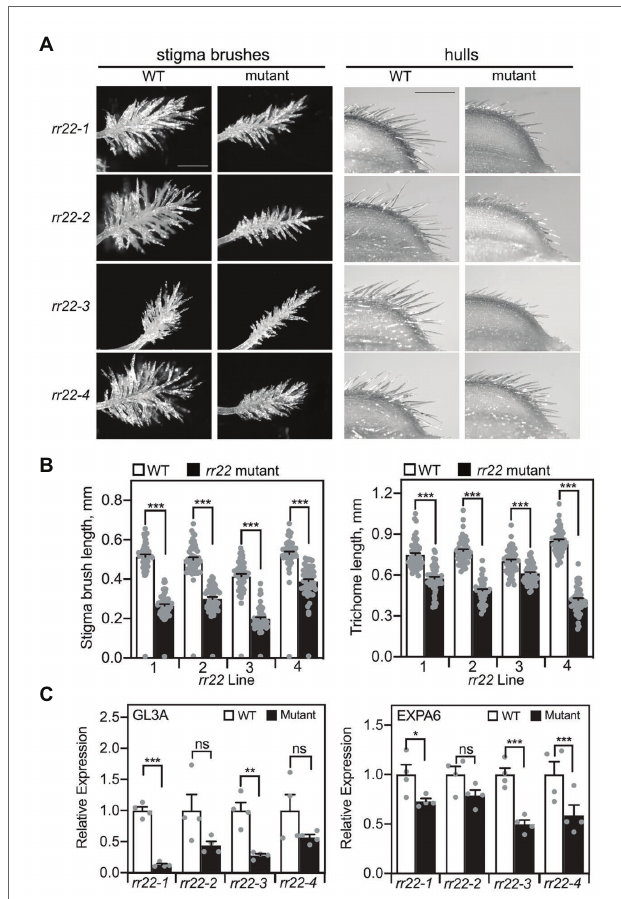
FIGURE 7 | Trichome-related phenotypes of Tos17 rr22 lines. (A) Stigma brushes (scale bar = 0.5 mm) and trichomes on grain hulls (scale bar = 1 mm). (B) Stigma brush hair length and hull trichome length, with the five longest hairs or trichomes measured per stigma or hull, respectively ( n = 50). (C) Expression analysis by qRT-PCR of the stigma-enriched genes GL3A and EXPA6 in carpels of rr22 mutants and their WT siblings ( n = 4). Expression of the UBQ5 gene was used for normalization. Error bars are for SE. The T -test was used for statistical comparison of each rr22 line to its WT sibling (* p < 0.05; ** p < 0.01; *** p < 0.001; ns, not